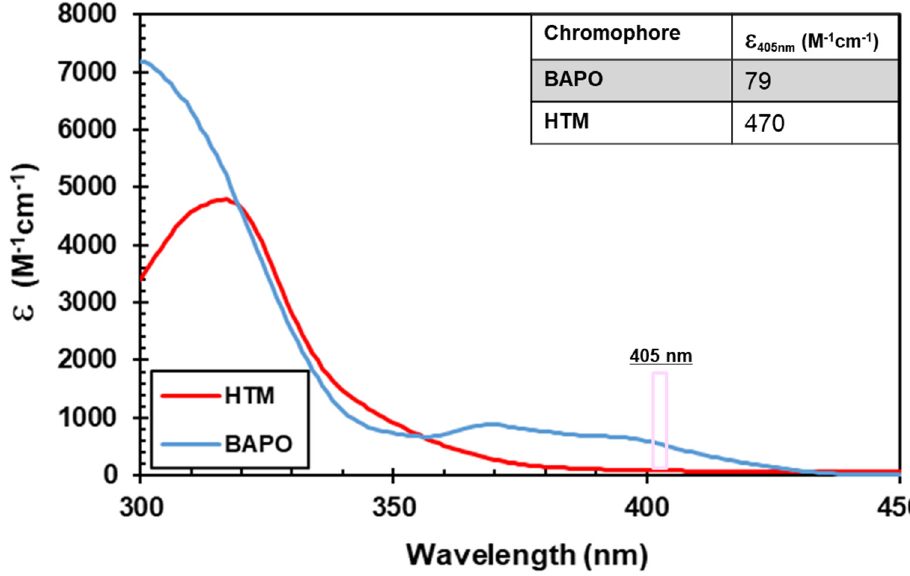
Figure 4. Molar extinction coefficient from Uv/Vis of biobased monomer HTM and BAPO in MeCN solvent.